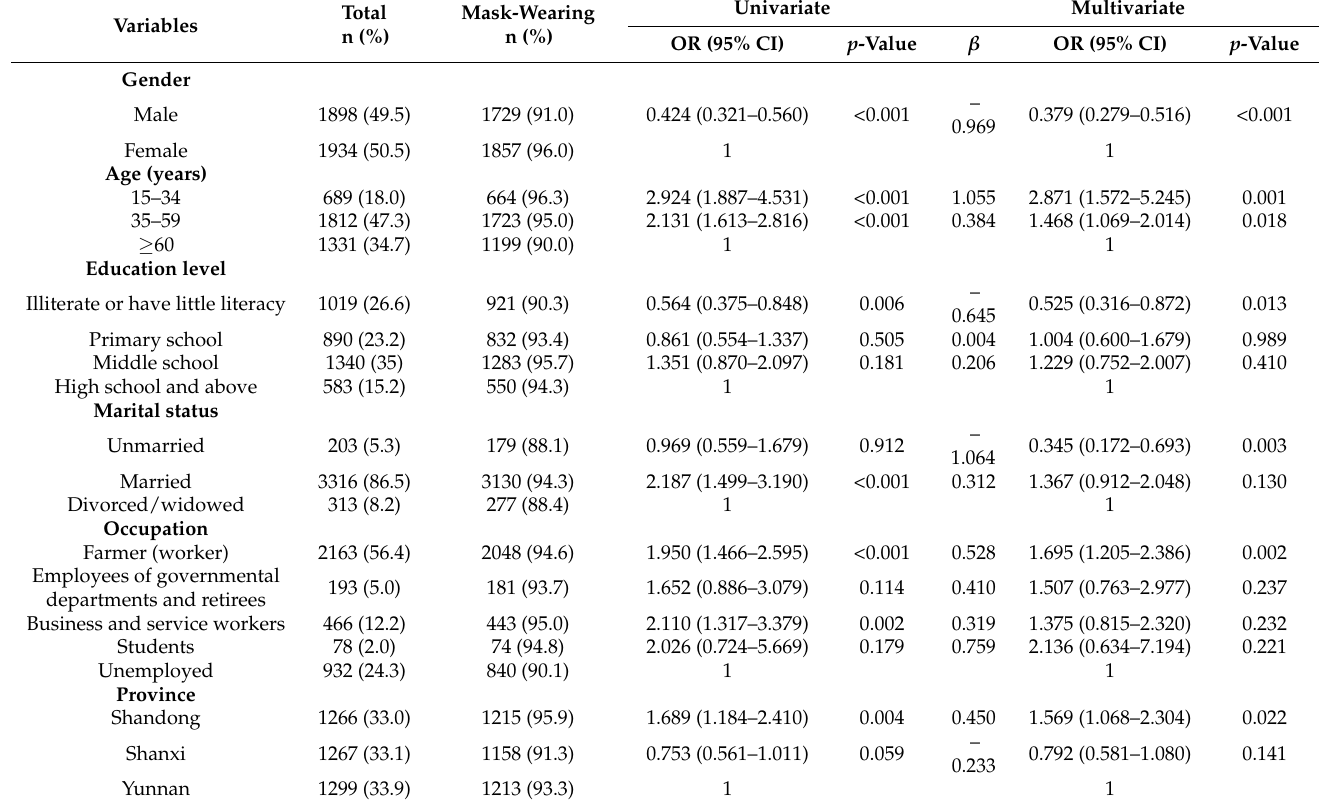
Table 3. Logistic regression analysis for influencing factors of mask-wearing (n =